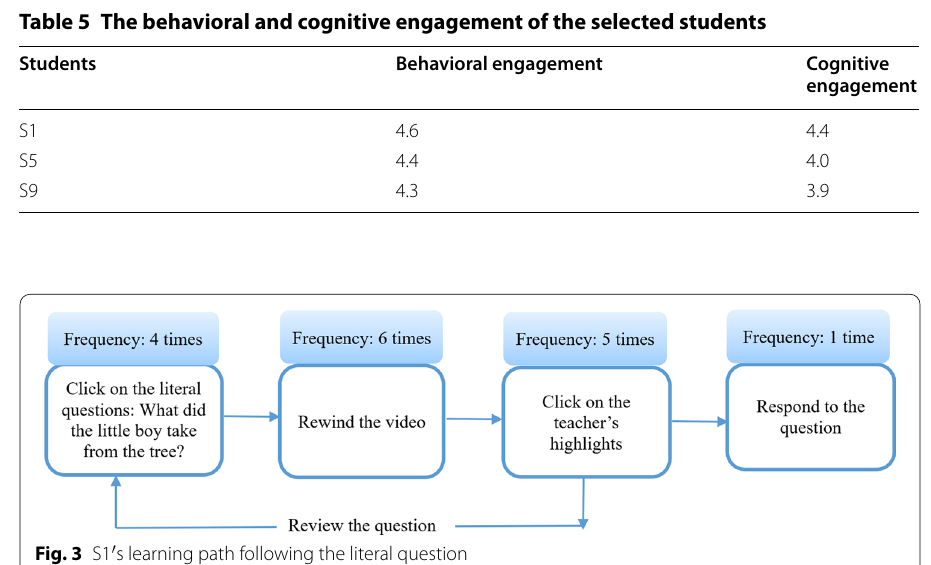
Table 4 The total number of student clicks on the teacher annotations (N Types of teacher annotations